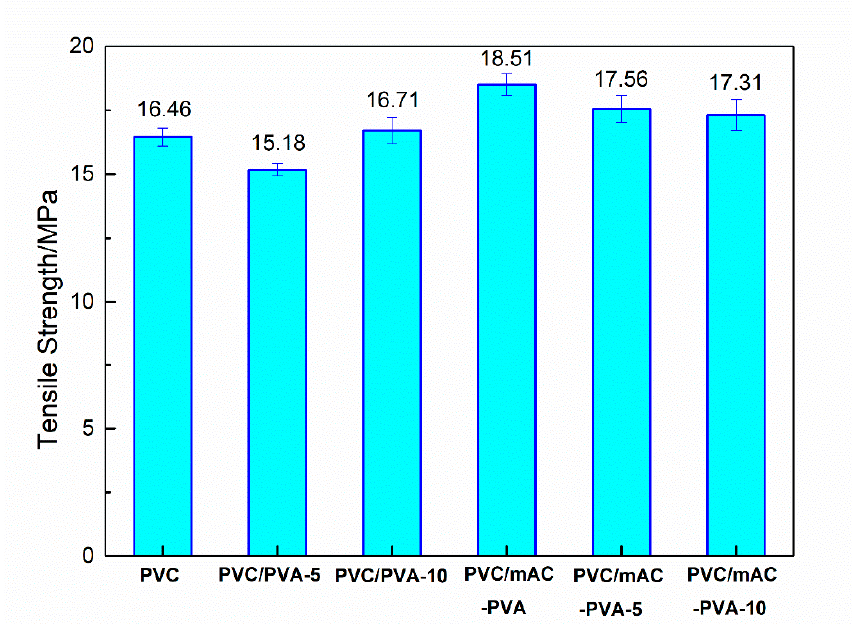
Figure 15. Tensile strength of the PVC biofilm carrier.